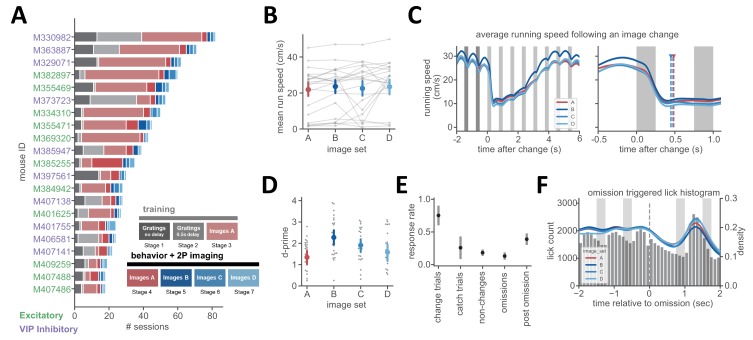
Behavior is similar across image sets.(A) Number of sessions in each training stage for all mice in the study. Slc17a7+ mice are shown in green and VIP+ mice are shown in purple. Inset shows color legend for training stages. (B) Average running speed is similar across image sets (p>0.05 for all image set comparisons, Welch’s t-test used for all statistical comparisons, see Materials and methods for additional details). Mean running speed is computed for each stimulus presentation within a session then averaged across the session. Gray lines indicate session average running speed for each mouse, colors indicate average across mice with 95% confidence intervals. (C) Average change triggered running speed is similar across image sets. Right panel shows slowing of running behavior following a stimulus change, with median lick latency (values from Figure 1J) for each image set indicated by arrows and dotted lines. (D) Mean d-prime is similar across image sets (p>0.05 for all image set pairs except A-B, where p=0.002). (E) Average licking response rate (± SEM) measured for image change trials, catch trials, all non-change stimulus presentations, stimulus omissions, and for the stimulus presentation immediately following an omitted stimulus. (F) Pattern of mouse licking behavior around the time of stimulus omission is similar across image sets. Gray bars show histogram of lick counts in each time bin pooled over all mice (left y-axis). Colored lines show kernel density estimate of lick distribution over time for each image set (right y-axis).